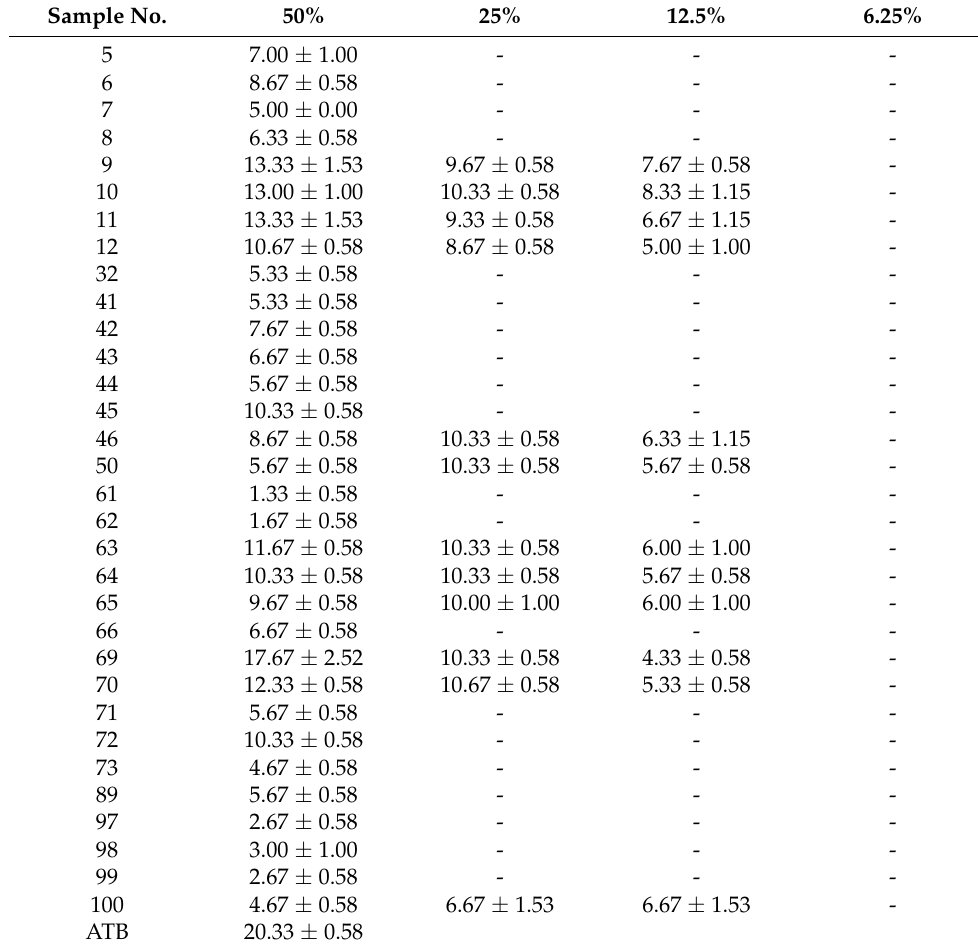
Table 3. Antimicrobial activity of samples against P. aeruginosa in mm. Sample